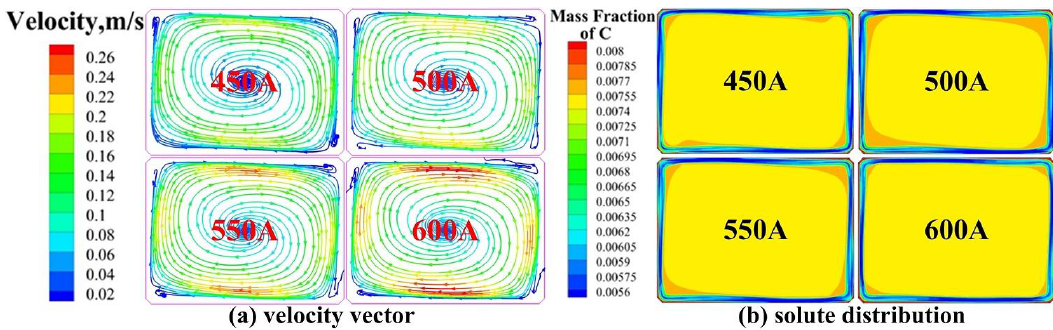
Figure 16. Velocity vector ( a ) and distribution of element C ( b ) at EMS center.